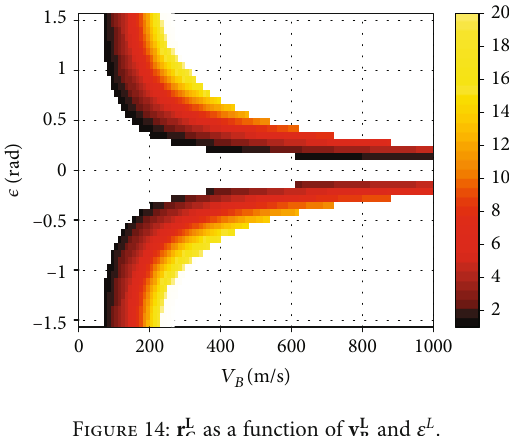
as a function of v L C